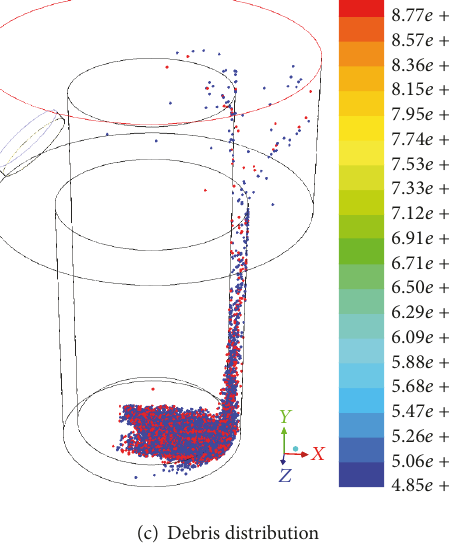
Figure 17: Schematics of gap flow field with flushing at 5 m/s and 3.5 mm deep